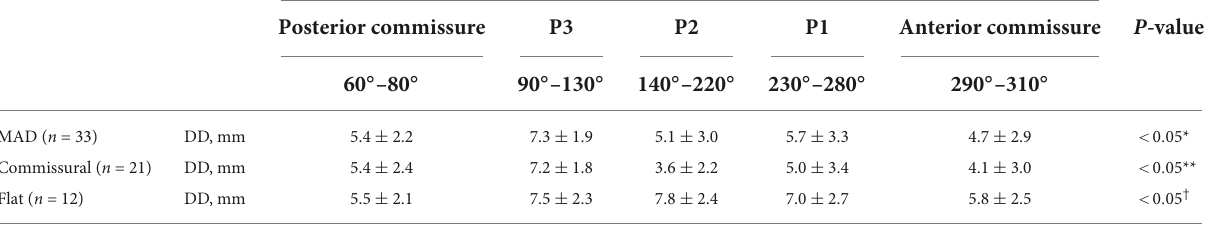
TABLE 3 Annular and leaflets measurements.